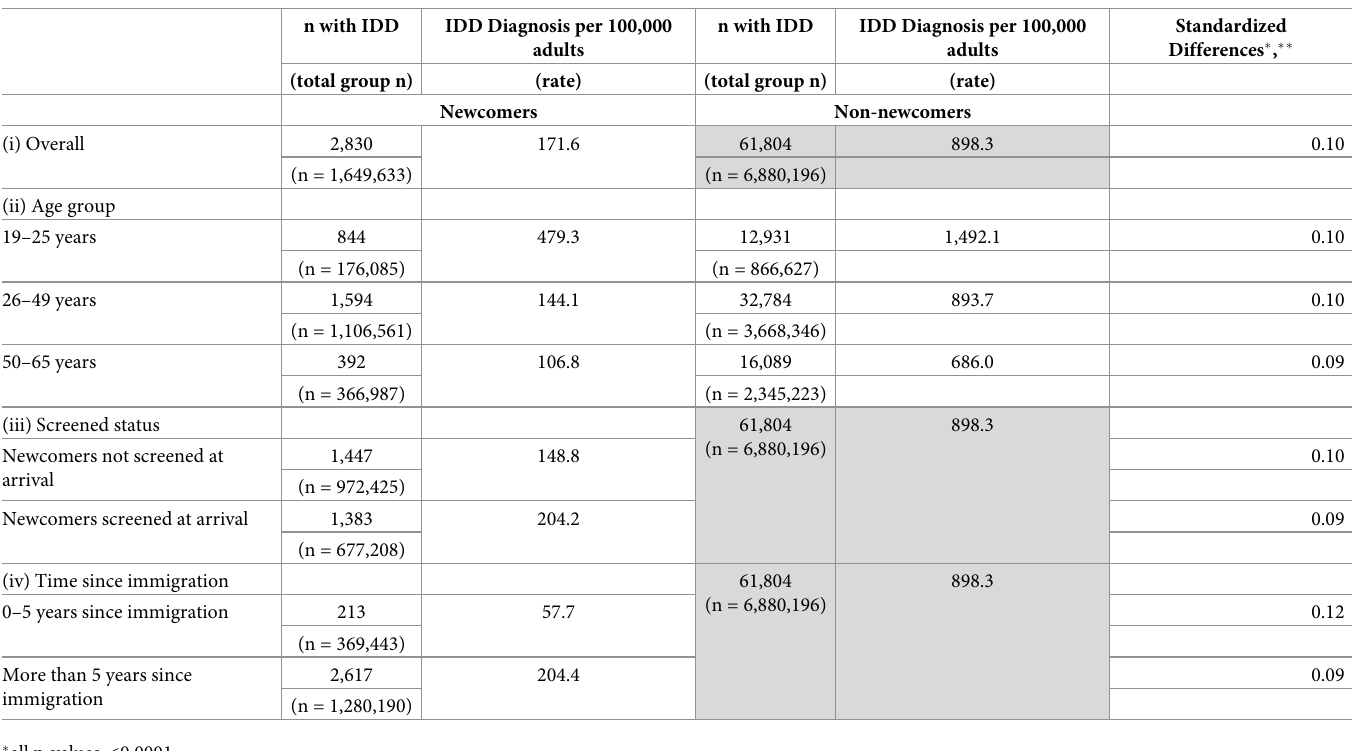
Table 1. Prevalence of intellectual and developmental disabilities (IDD) per 100,000 population among newcomers versus non-newcomers (i) overall, (ii) by age group, and within newcomer groups, (iii) with different eligibility criteria, and (iv) with different lengths of time since immigration to Canada, aged 19–65 years in Ontario, Fiscal year